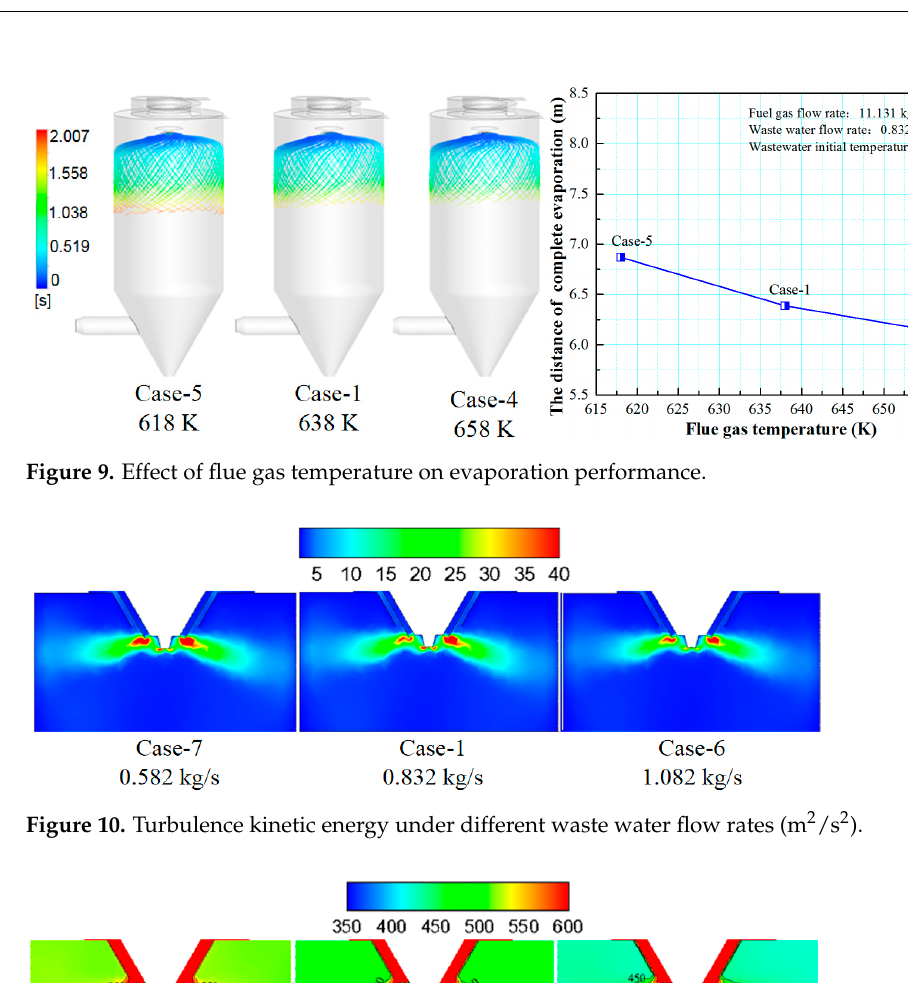
Figure 9. Effect of flue gas temperature on evaporation performance.